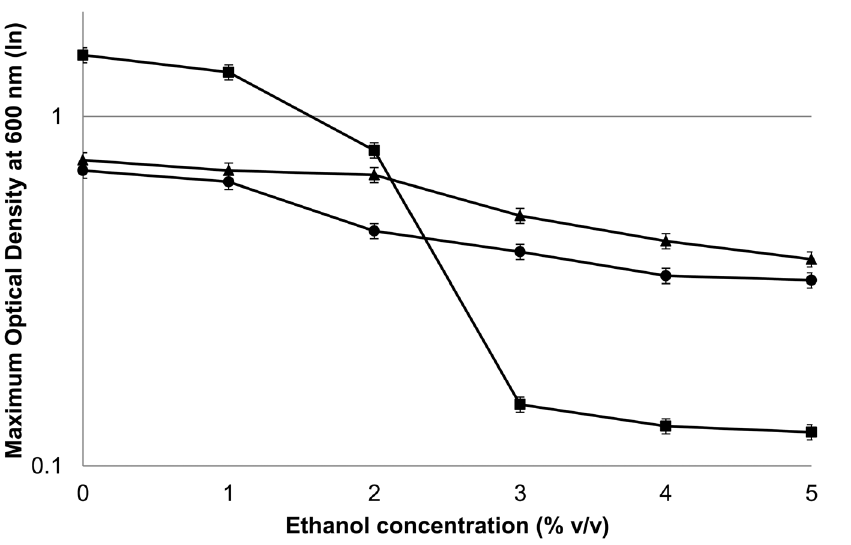
Figure 6. Maximum optical density (OD) attained by wild type and mutant strains of Clostridiumthermocellum on rich medium supplemented with 0–5% (v/v) added ethanol. Symbols: closed square, C. thermocellum wild type; closed circle, C. thermocellum adhE* (EA); closed triangle, C. thermocellum adhE* (EA) D ldh .